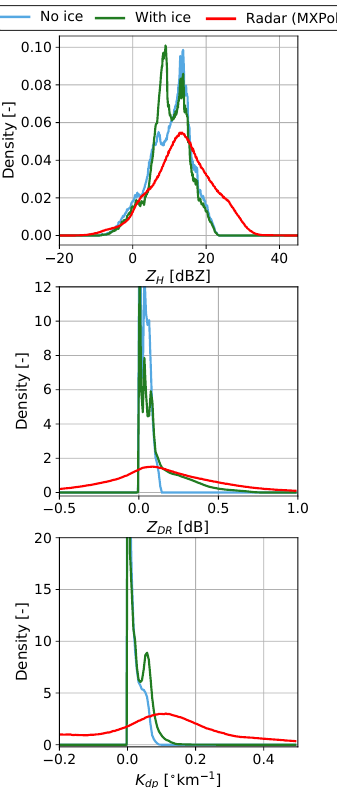
Figure 21. Observed and simulated (with and without ice crystals) distributions of polarimetric variables during three pure snowfall events for the one-moment microphysical scheme.